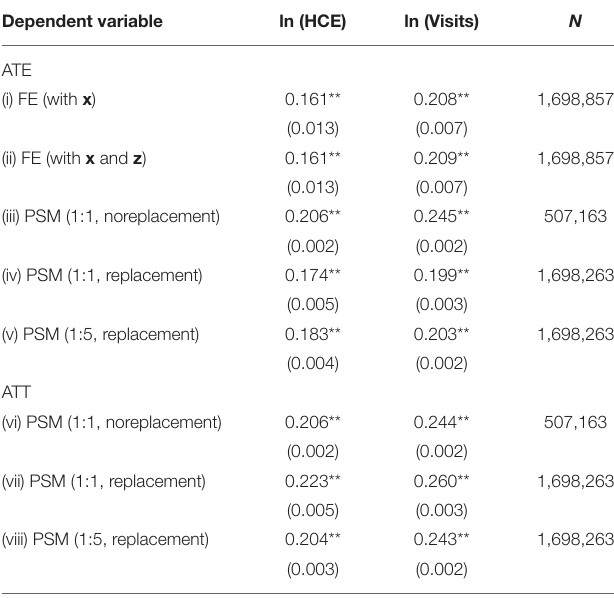
TABLE 3 | Effect of PA assignment on healthcare